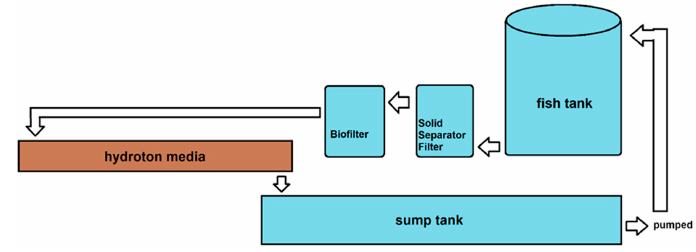
Figure 1. Aquaponic water flows experimental design.